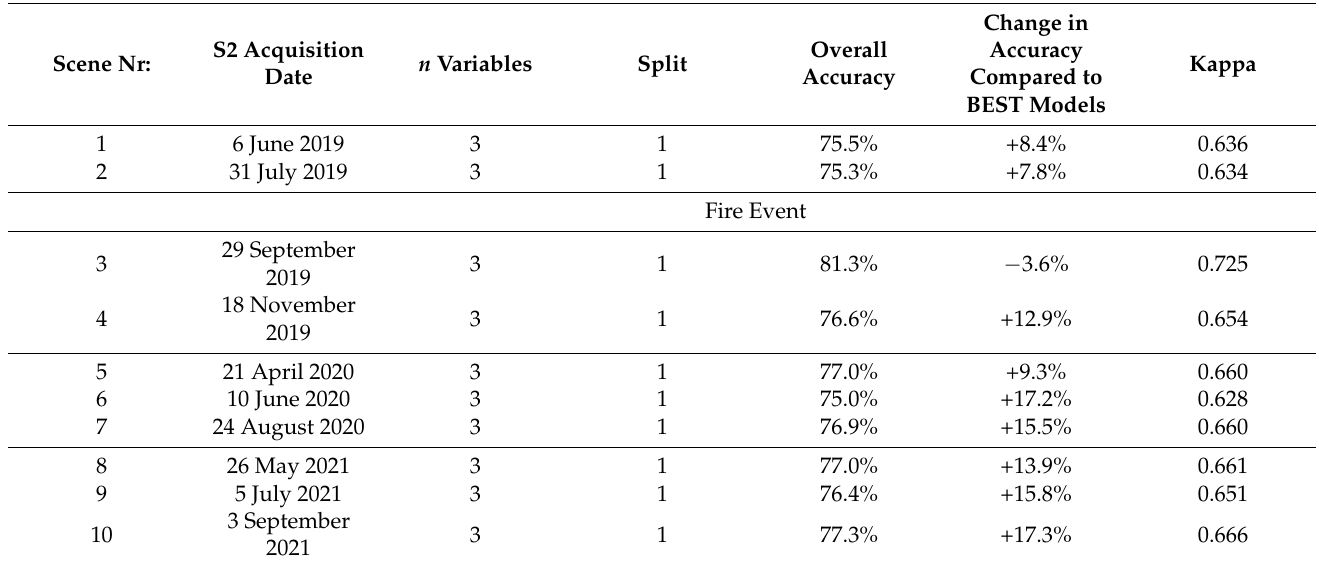
Table 5. Random Forest models using three Vegetation Indices (LCCI, NDRESWIR, REPA) from single Sentinel-2 data recording